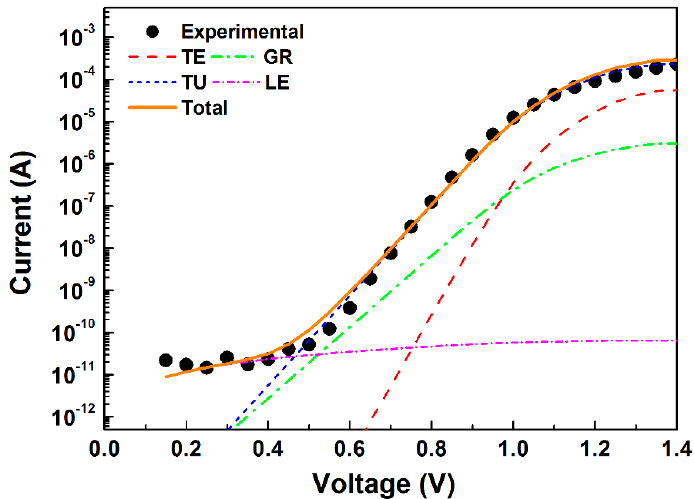
Figure 4. The fitting results of the forward I – V data at 298 K for a 10 nm thick AlGaN sample are shown.